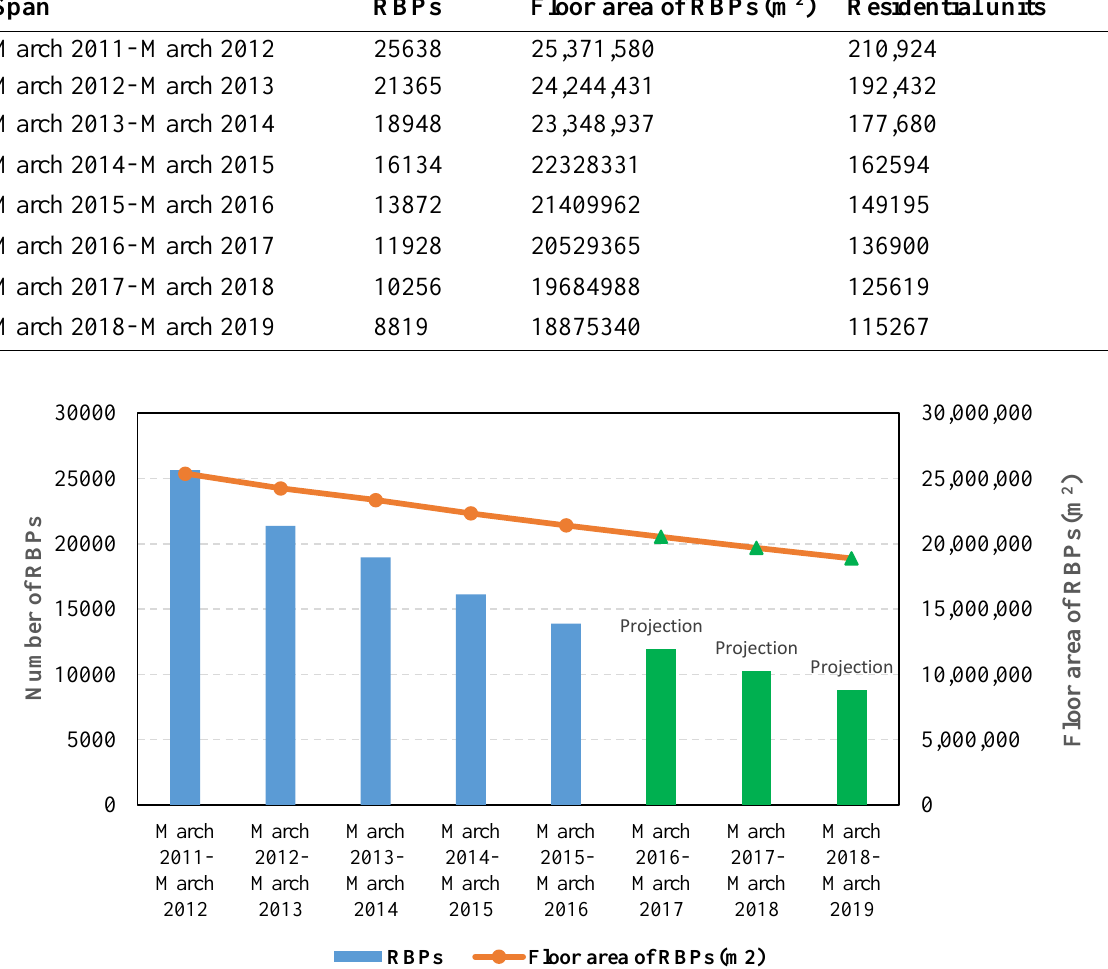
Table 1 . Issued RBPs in last three years and predicted for 2014-2019 . Span